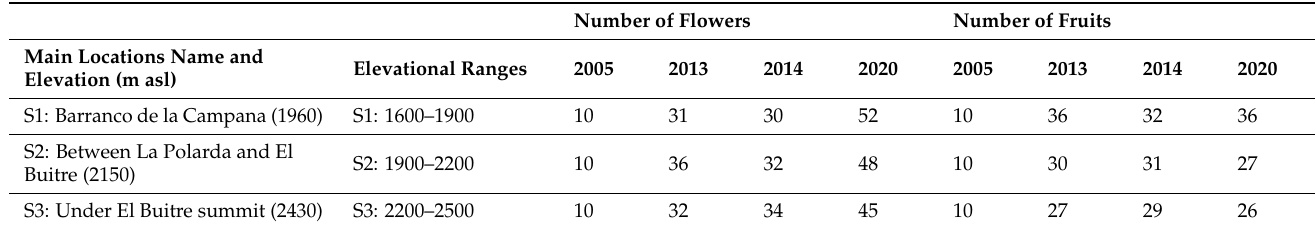
Table 7. Number of flowers and fruits collected at each elevational range per year. Number of Flowers Number of